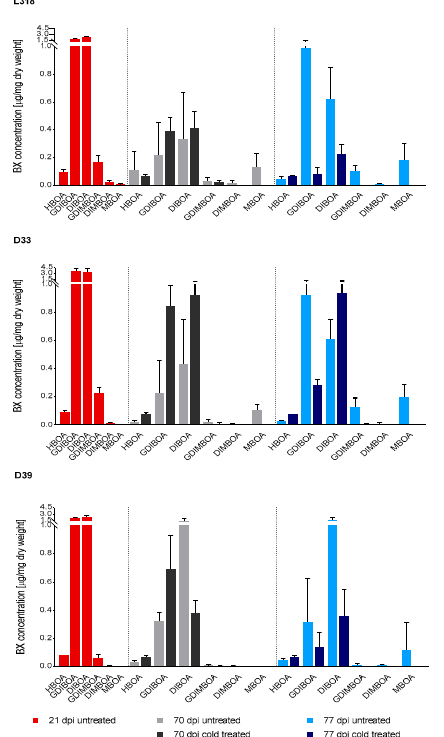
Figure 3. Benzoxazinoid (BX) concentrations in untreated and cold-treated plants of the rye inbred lines L318, D33, and D39 measured at 21, 70, and 77 days after germination. The results are presented as means ± SD of four biological replications. The significance of differences in BX concentrations between untreated and cold-treated plants (assessed using the Mann–Whitney U test) are presented in Table 3.